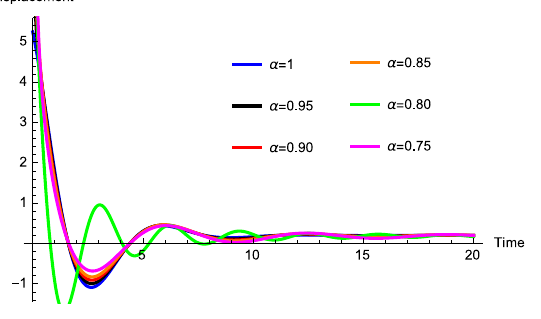
Figure 3. Numerical simulation for Equation (19) considering different values of α , arbitrarily